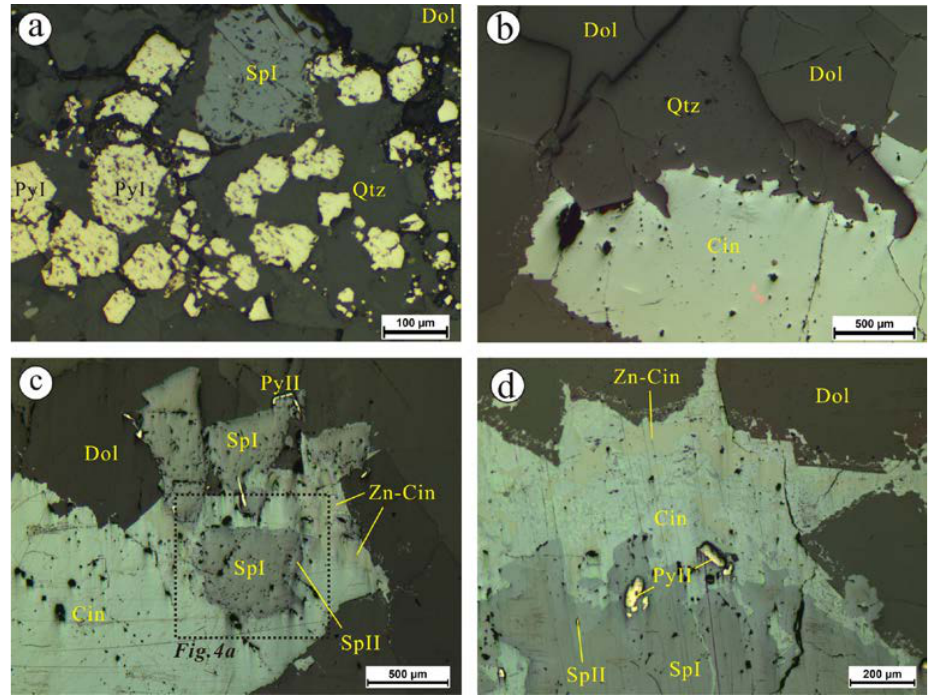
Figure 3. Photomicrographs of ore minerals and textures in the Chashula deposit: ( a ) euhedral to subhedral first-generation pyrite I (PyI) with sphalerite I (SpI) in quartz (Qtz); ( b ) cinnabar (Cin) filling quartz (Qtz) and dolomite (Dol); ( c ) sphalerite I and Zn-bearing cinnabar (Zn-Cin) replaced by cinnabar (Cin); and ( d ) sphalerite I replaced by sphalerite II (SpII), and the Zn-bearing cinnabar (Zn-Cin) replaced by cinnabar (Cin).